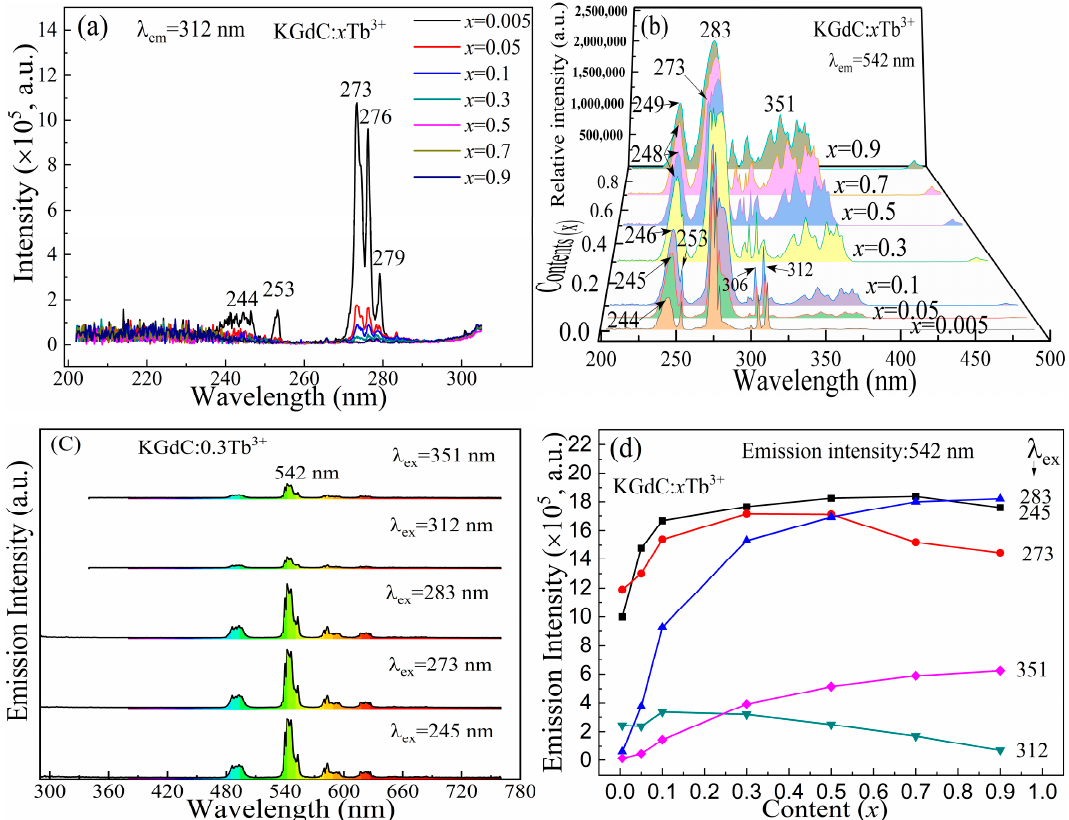
Figure 4. Luminescence properties of KGdC:xTb 3+ ( a ) Excited spectra monitored at 312 nm; ( b ) Ex- cited spectra monitored at 542 nm; ( c ) Typical emission spectra of KGdC:0.3Tb 3+ at different exciting wavelengths; ( d ) 542 nm emission intensities.